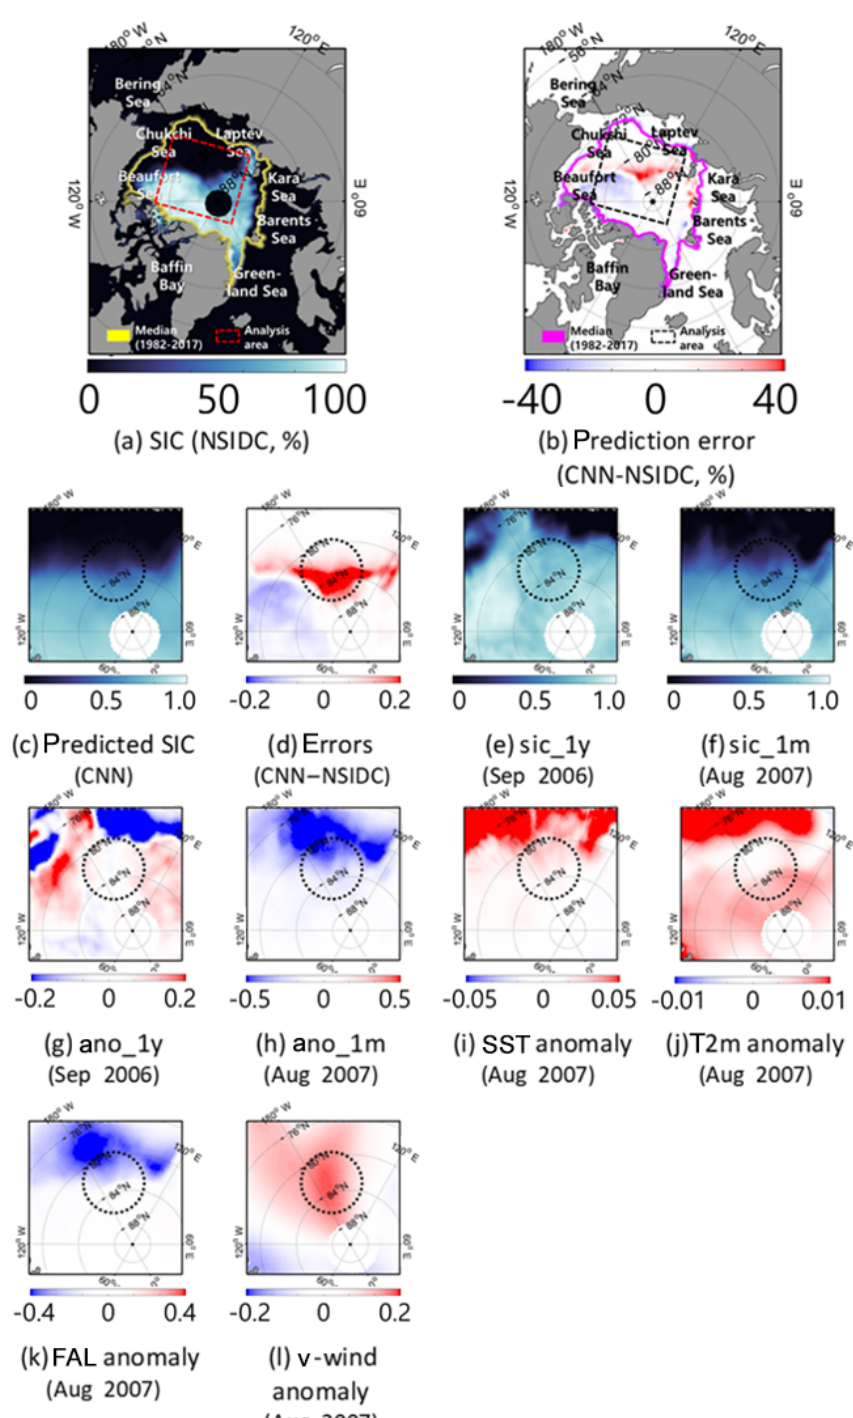
Figure 10. Comparison of the prediction results of both models with eight input variables in the Beaufort Sea–Laptev Sea in September 2007. The dotted black circle is the region showing higher prediction